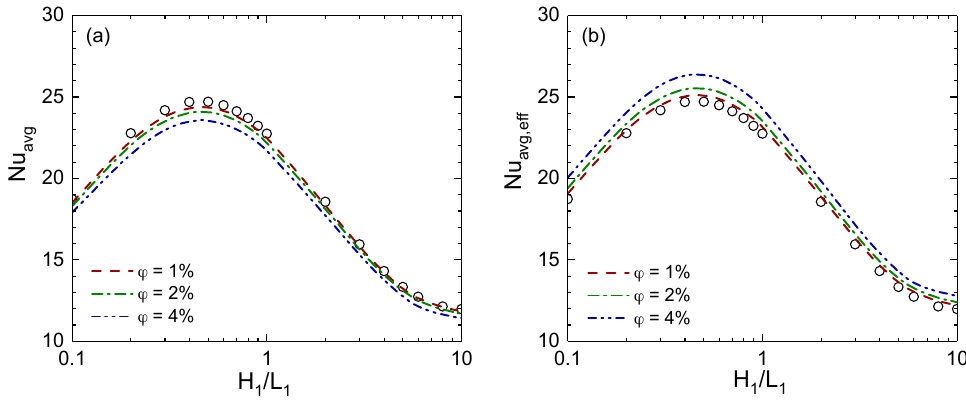
Figure 16. Effect of Al 2 O 3 -volume fraction on the average Nusselt number. ( a ) Average Nusselt number based on nanofluid properties (denoted as Nu avg ) and ( b ) effective average Nusselt number based on base fluid conductivity (denoted as Nu avg,eff ). The variations of Nu avg and Nu avg,eff are depicted for Re = 1000, Ra = 10 5 , and φ = 0.05. Different line types correspond to different Al 2 O 3 -volume fractions as indicated in the legend and symbols are for the base fluid case.